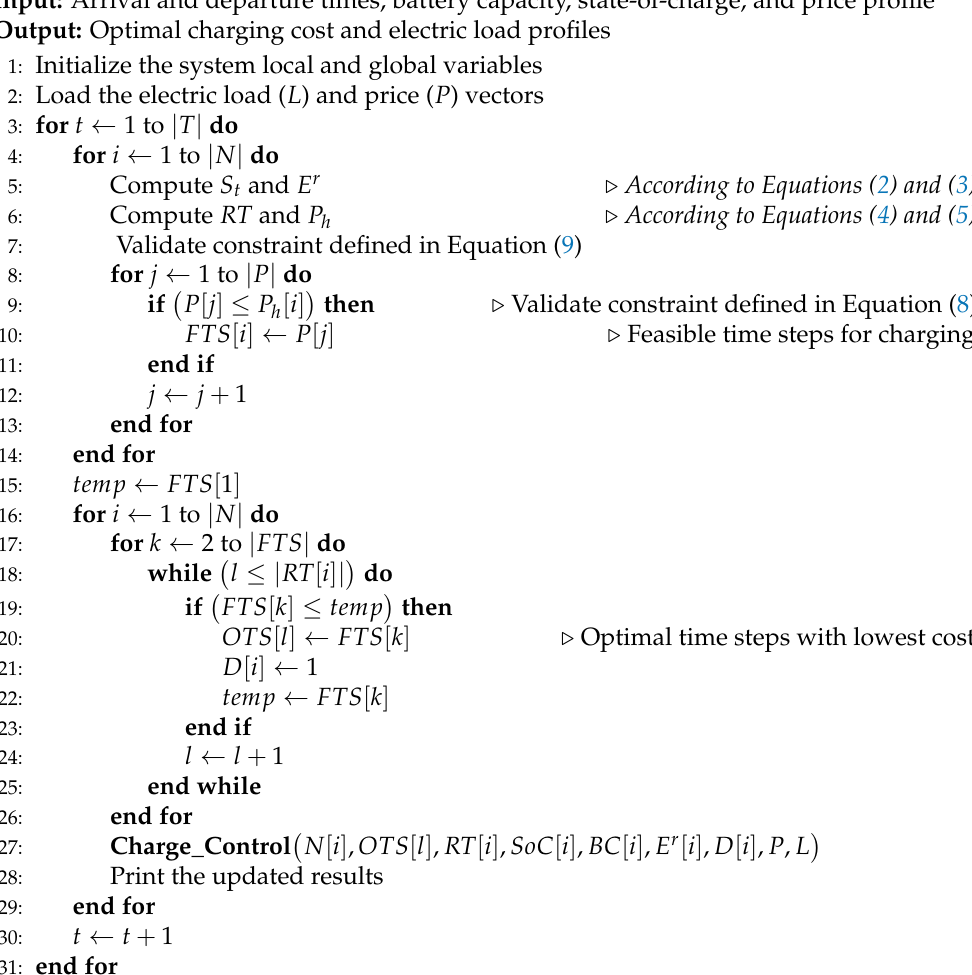
Algorithm 1 Main Algorithm of the proposed charging cost optimization algorithm